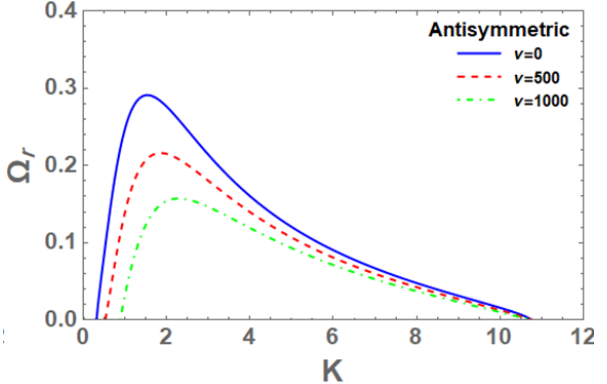
Figure 13. Non-dimensional growth rate Ω r and non-dimensional wave number K for different gas to liquid viscosity values ν , when We = 2000; Oh = 2; N = 1; v = 0.2; ρ = 0.1; U = 1.5; ˜ (cid:101) l = 0.3; ˜ (cid:101) g = 0.1; E = 10; V (cid:48) = 5; for axisymmetric disturbance